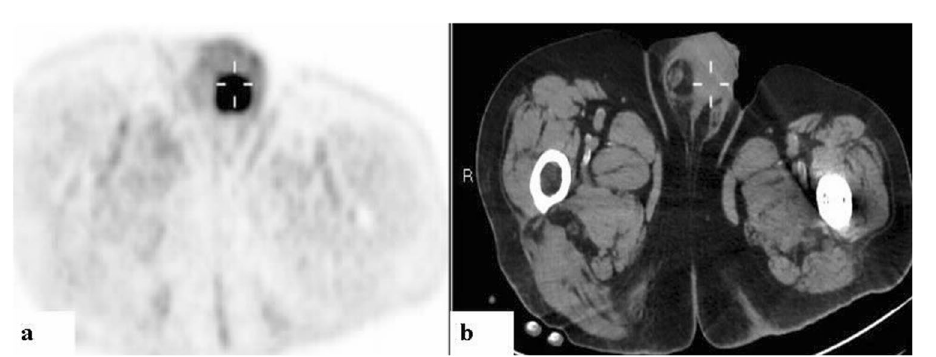
Figure 5. 18F-FDG PET ( a ) and CT ( b ) axial slices demonstrating focally increased uptake at the root of the penis. An 80-year-old man with metastatic high-grade pelvic leiomyosarcoma (patient #23, Table